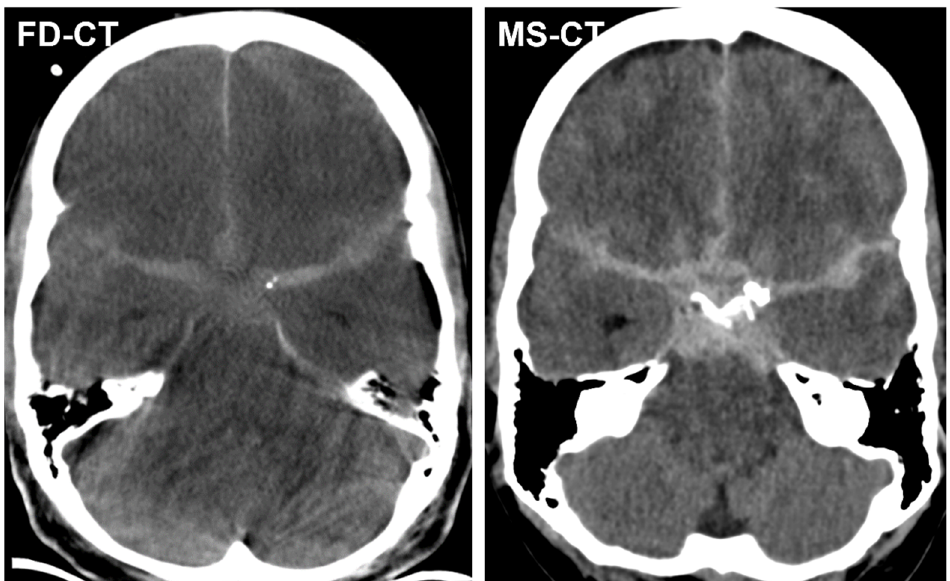
Figure 1. Exemplary flat-detector computed tomography (FD-CT) and multislice computed tomography (MS-CT) images of a patient with an endovascular treated, aneurysmal subarachnoid haemorrhage (SAH). Both FD-CT and MS-CT allow the delineation of the SAH as hyperdense filling of the subarachnoid spaces around the circle of Willis.